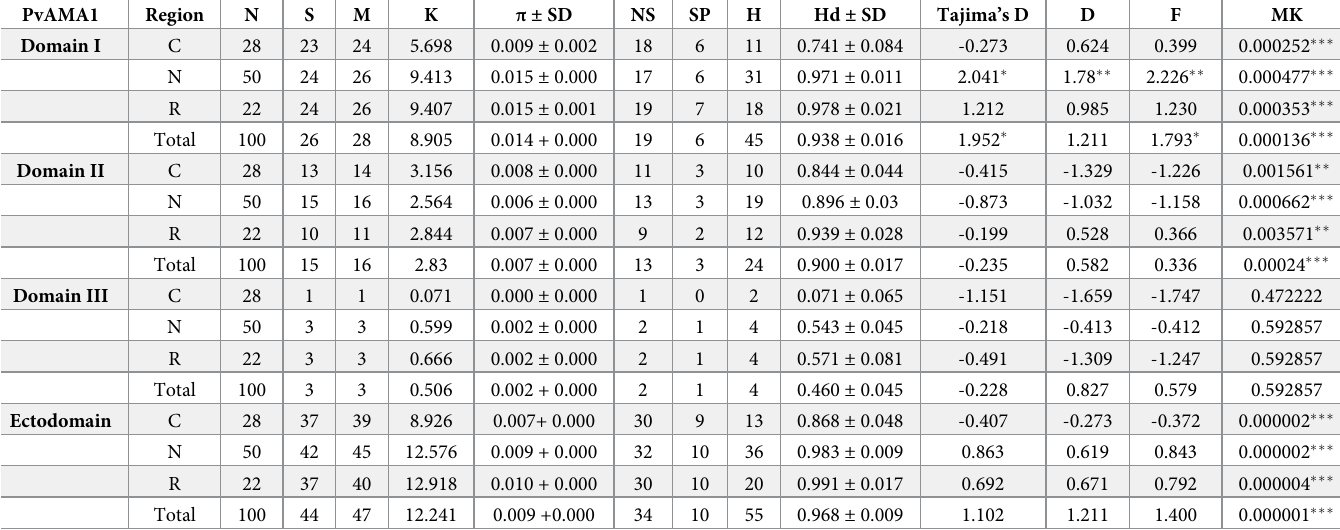
Table 1. Estimates of genetic diversity and test of neutrality for Pvama1 in three Indian